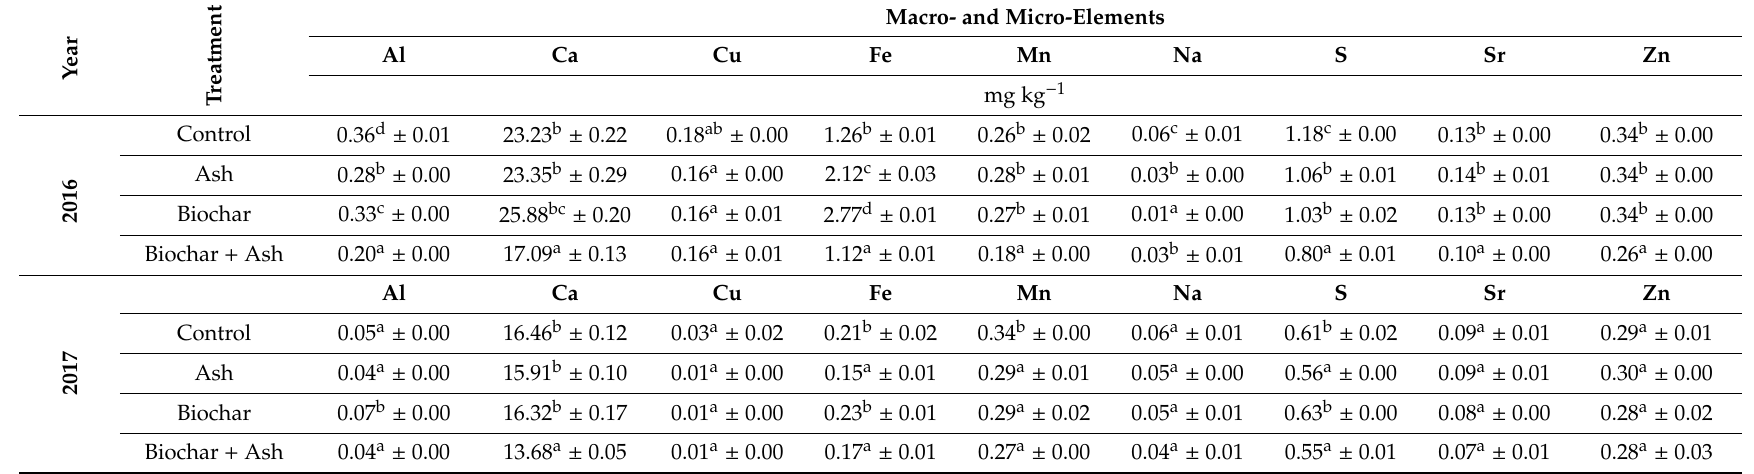
Table 3. Mean concentration of selected macro- and micro-elements, as well as heavy metals ( ± SD) in the pyrolysates produced from basket willow biomass, in the first and second year of the study, relative to the treatment applied ( n =